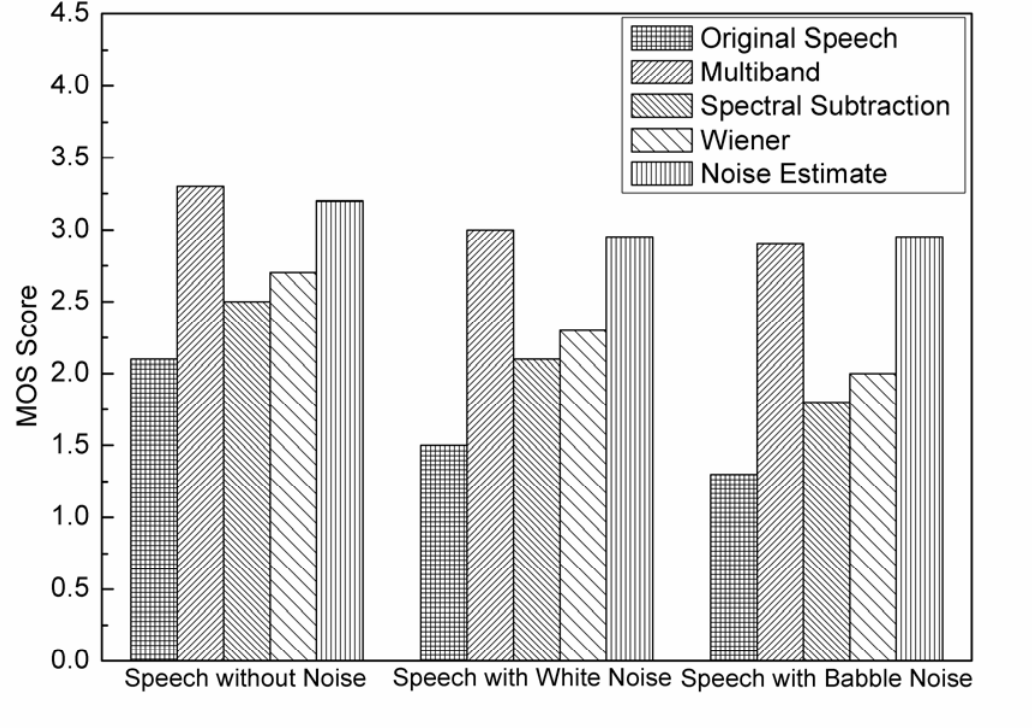
Figure 5. Acceptability scores of the original and enhanced EL speech. The noisy speech in the case of additive noise has an input SNR of 0